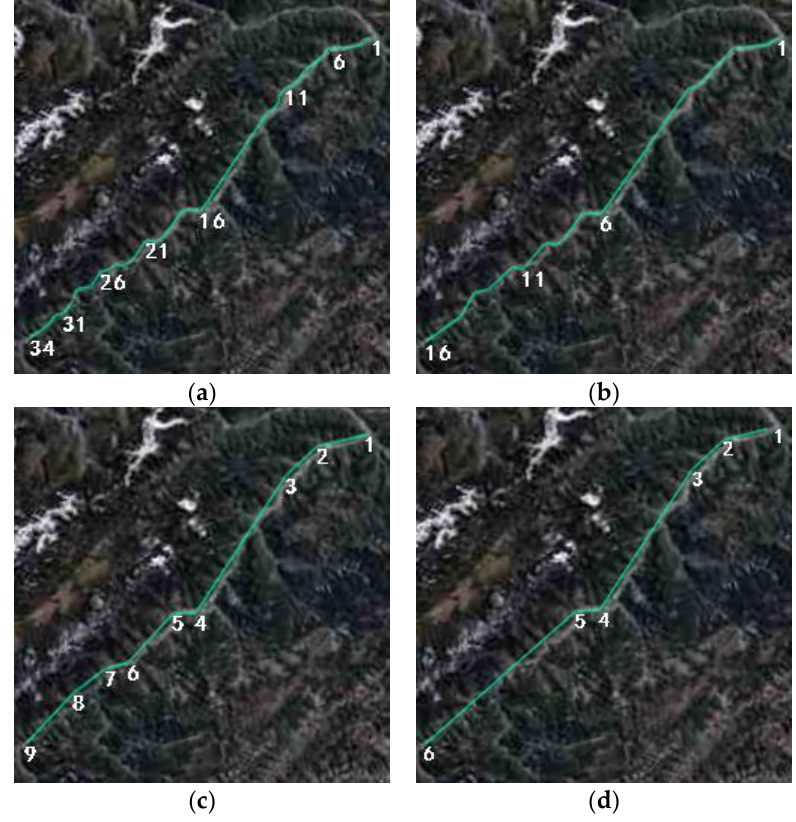
Figure 15. Comparison results for different tolerances ϵ . ( a ) ϵ = 0.25 nmi; ( b ) ϵ = 0. 50 nmi; ( c ) ϵ = 0.75 nmi; ( d ) ϵ = 1.00 nmi. Table 4. Comparison results for different tolerances.